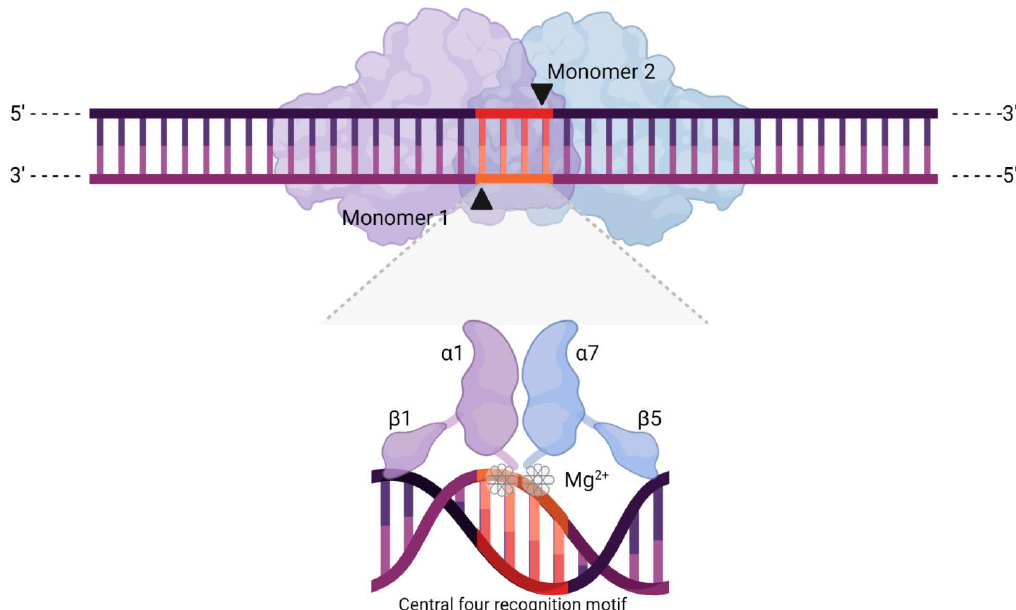
Figure 1. Schematic representation of a meganuclease (MN), depicting its two characteristic αββαββα domains, shown here as monomers of different colour. The arrows indicate the cleavage sites, resulting in a DSB with 4-nt 3′ overhangs. The highlighted section represents the central four recognition motif, shown at the bottom in close proximity to the MN active site. This set of four bases lies at the centre of the broader DNA recognition sequence and directly determines cleaving activity and specificity through a cofactor displacement mechanism. Effectively, mismatches in this motif produce structural rearrangements that displace metallic ions (Mg 2+ ) from the active sites.